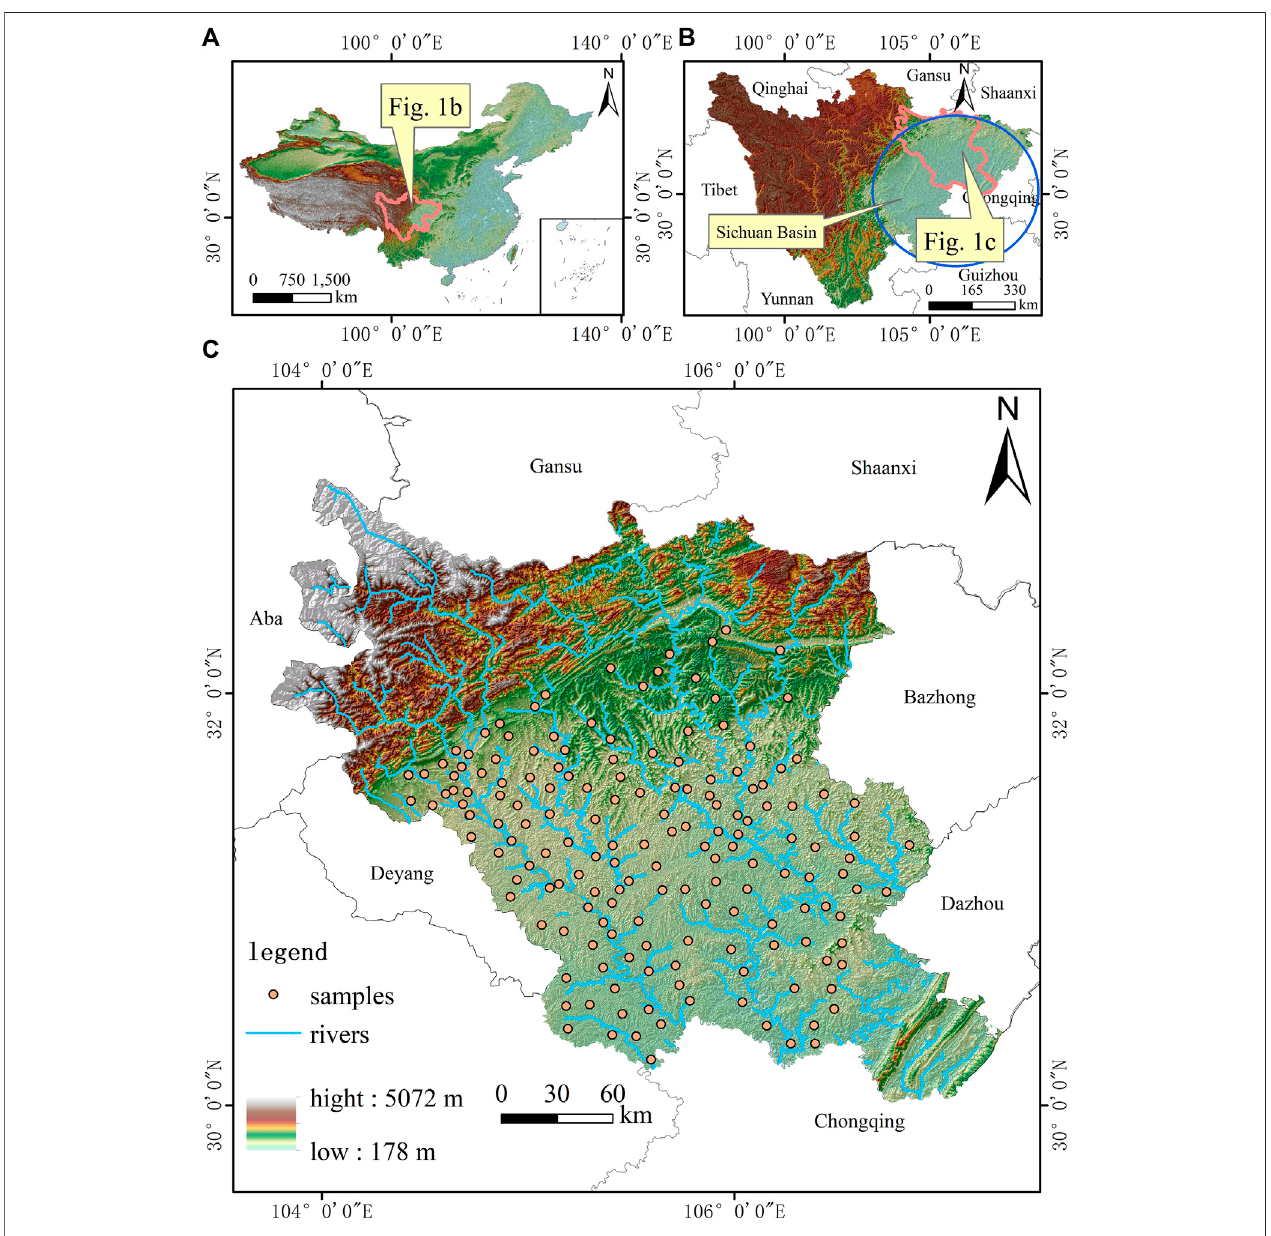
FIGURE 1 | (A) Location of Sichuan Province in China, (B) Location of the study area in Sichuan, (C) Sample points on the study area.